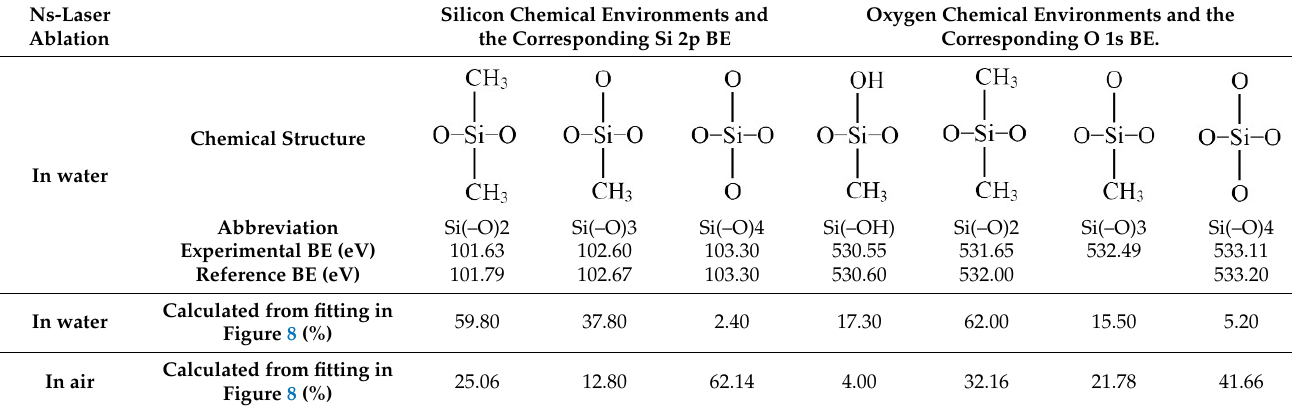
Table 2. Comparison of XPS data of the PDMS surface after ns-laser ablation within water and air. Ns-Laser Ablation